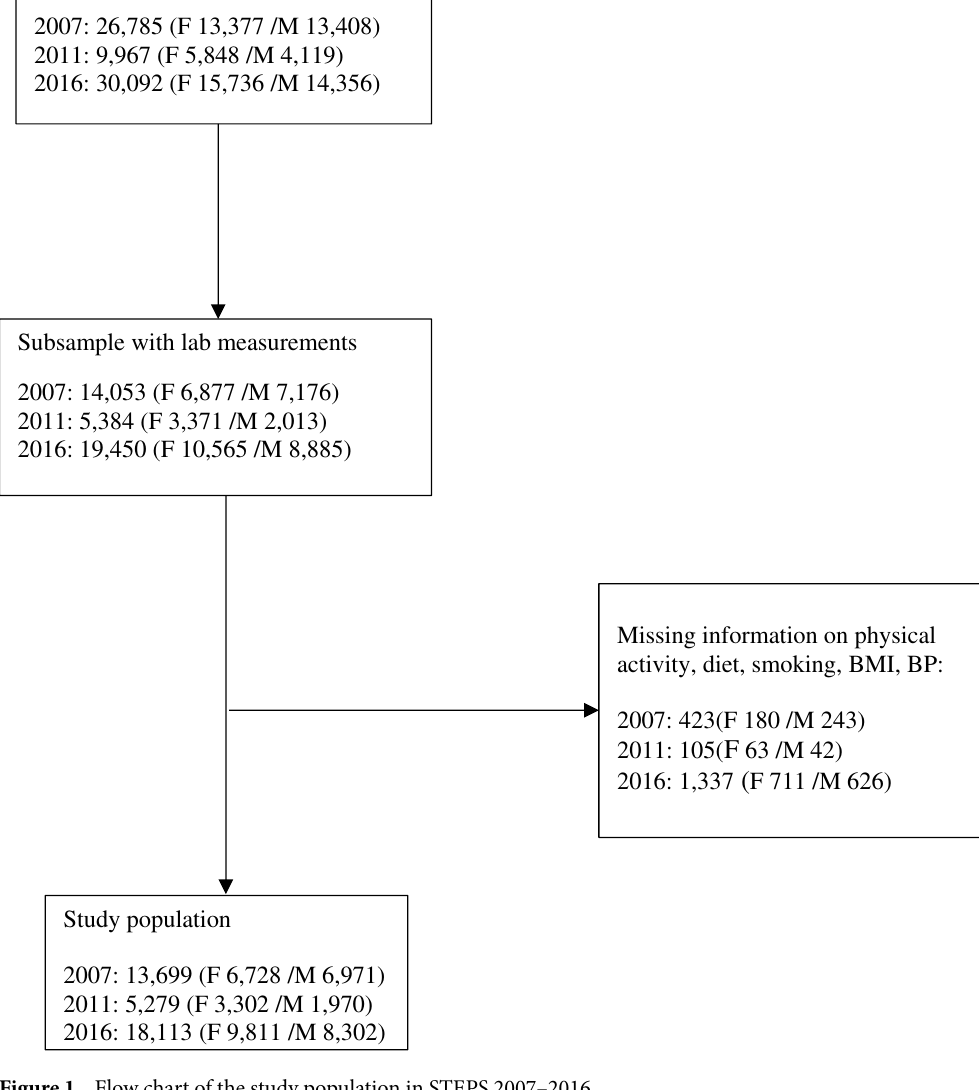
Figure 1. Flow chart of the study population in STEPS